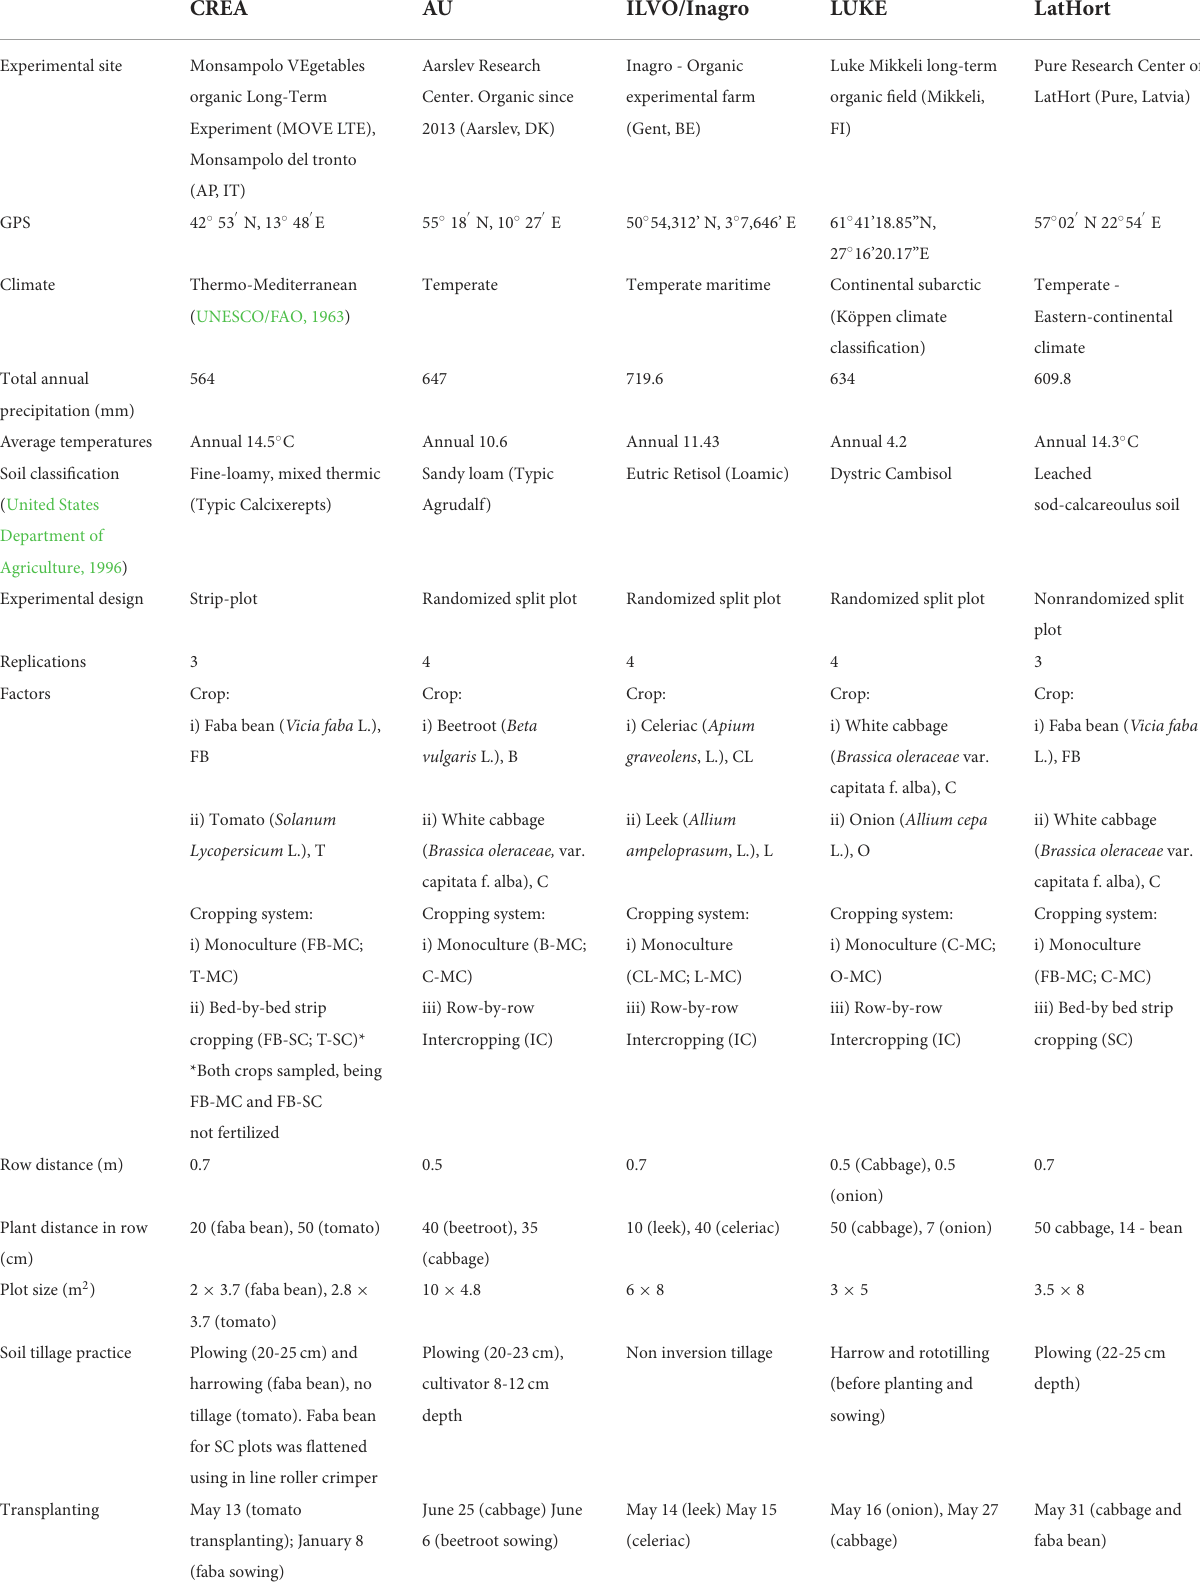
TABLE 1 Experimental sites description and management practices